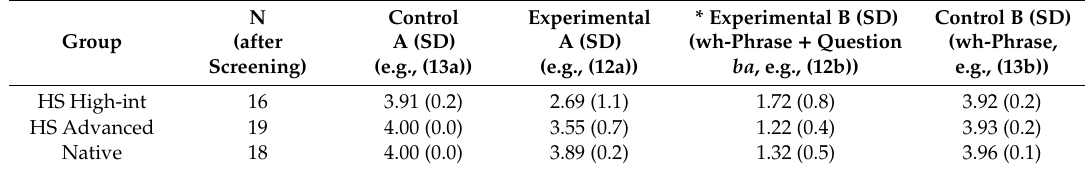
Table 2. Mean scores in the AJT for sentences testing the [Q] and [-wh] features of the question SFP ba. Group